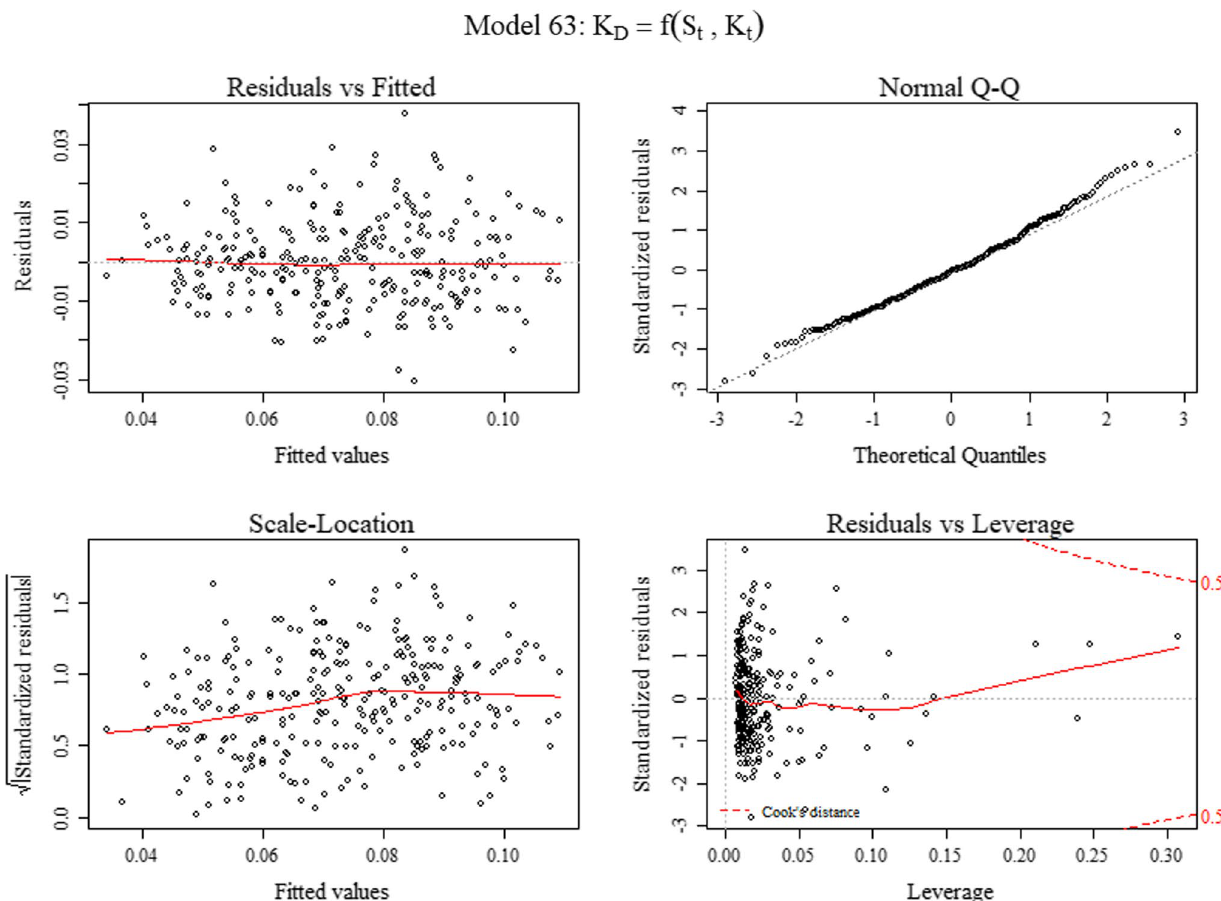
Fig. 5 Diagnostic plots of the best model of K